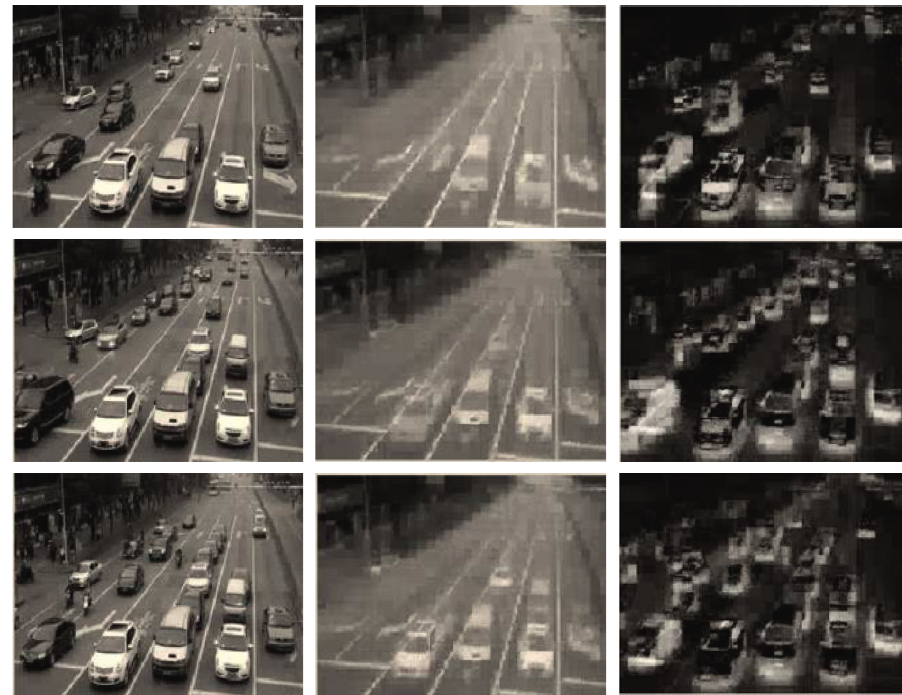
Figure 4: Detection results of the structured sparse representation